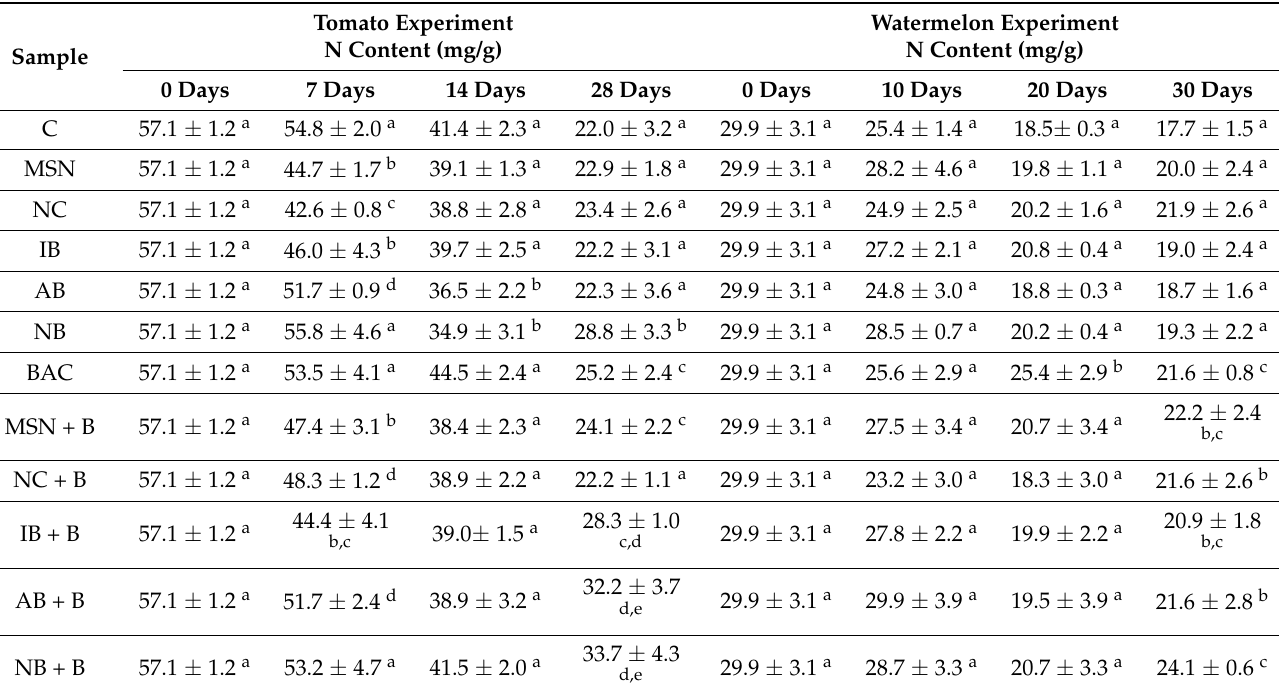
Table 3. N content (mg/g) in the 2nd tomato experiment and watermelon experiment